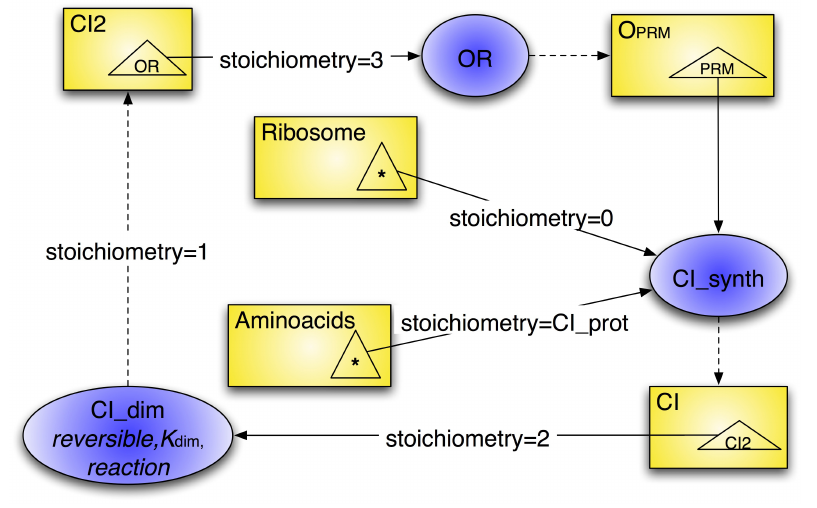
Figure 7: A MIN model representing the CI protein synthesis, including the participation of a ribosome (which acts as an enzyme) and of aminoacids (which play the role of